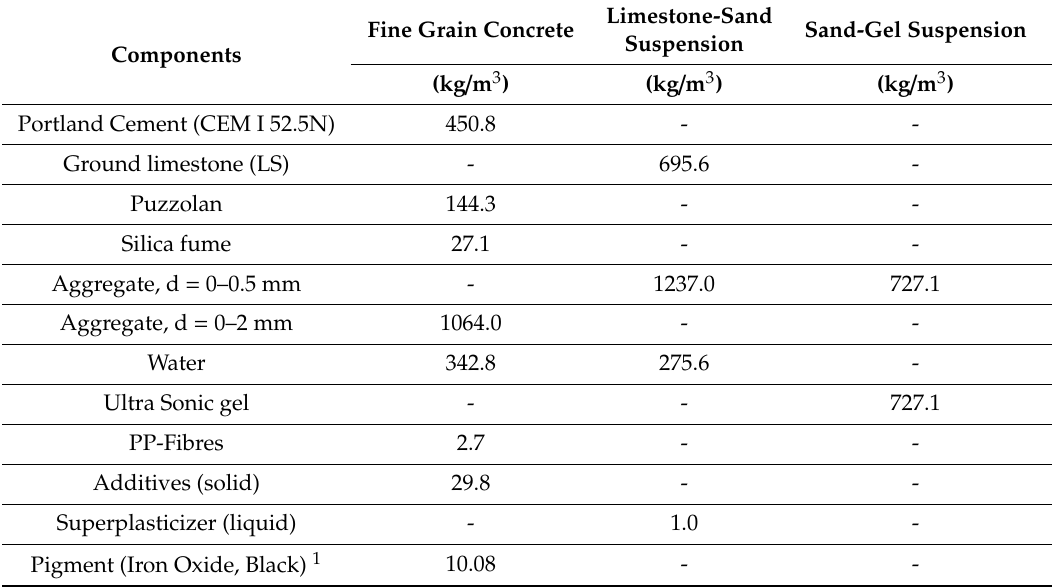
Table 1. Mixture compositions of used material.